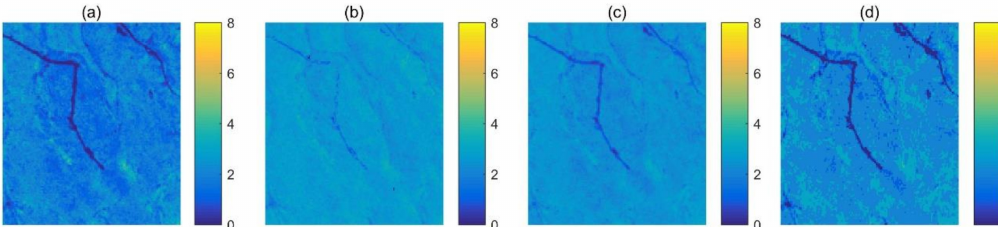
Figure 12. LAI maps with 30 m spatial resolutions at the Camerons site. ( a ) Based on the model-downscaling method proposed in this paper; ( b ) based on Ovakoglou’s downscaling method; ( c ) based on the model F ( P ) ; ( d ) the reference LAI map with 30 m spatial resolution obtained from the VALERI project.